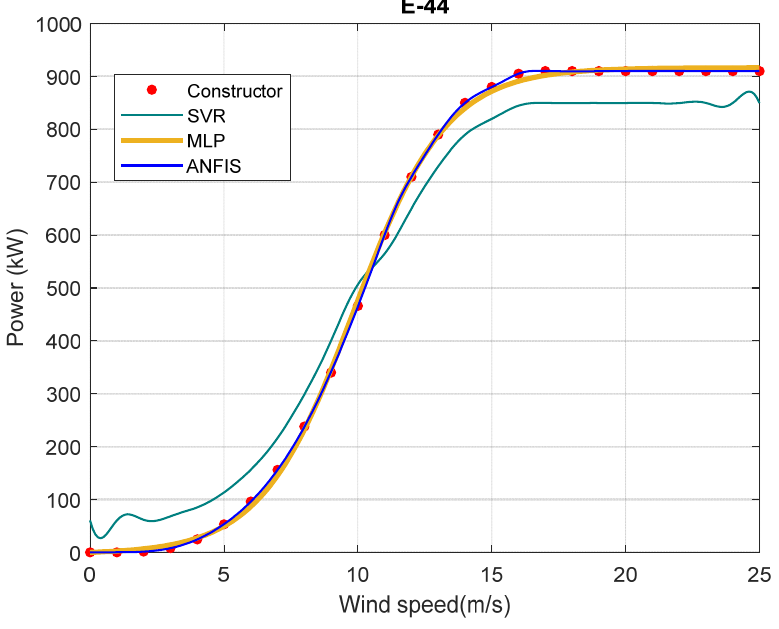
Figure 5. Characteristic power curve modeling for E-44.